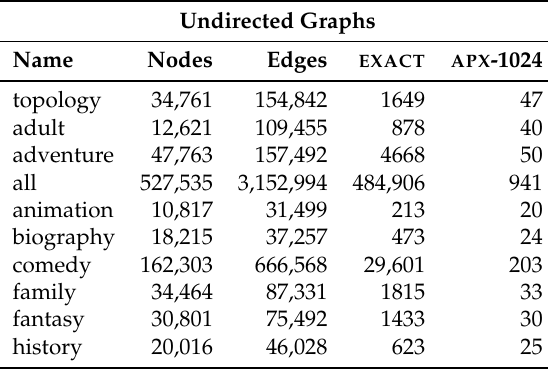
Table A1. Our dataset. For each graph we report the number of nodes, the number of temporal edges, and the running times (in seconds) of EXACT (the cell marked with * is an estimation) and APX -1024 (average among 50 experiments). The running times of APX - h , for any other value of h , can be estimated t /1024, where t is the running time of APX as h ·